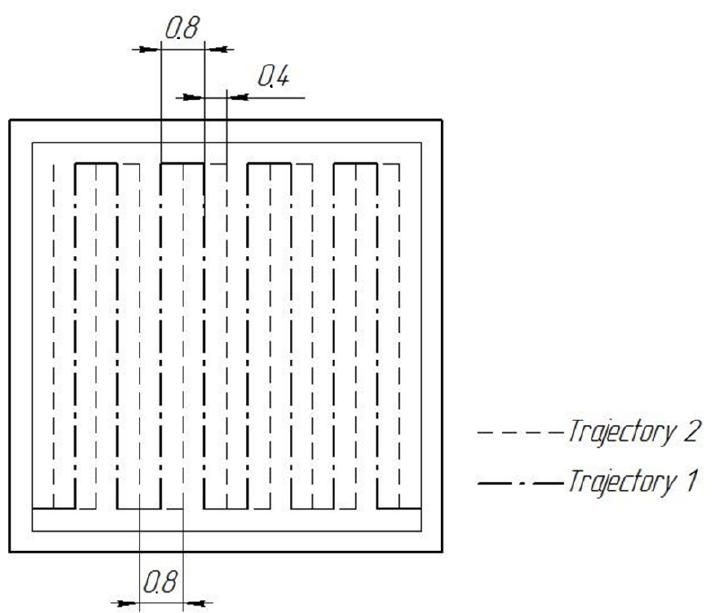
Figure 6. The sequence of track formation in the layer when printing samples.